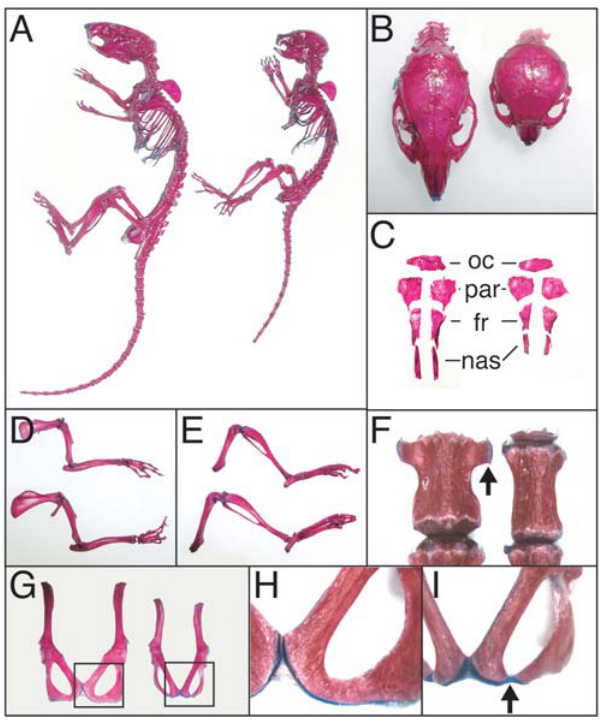
Figure 3. Skeletal defects in R26 floxneoWnt4 ; Col2a1-Cre mutants. Skeleton preparations from 6-week-old R26 floxneoWnt4 ; Col2a1-Cre mutants and R26 floxneoWnt4 controls. A, Intact skeletons, control (left) and mutant (right). B, Dorsal view of skulls, control (left) and mutant (right). C, individual dorsal skull bones, control (left) and mutant (right). D, Isolated forelimbs, mutant (top) and control (bottom). E, Isolated hindlimbs, mutant (top) and control (bottom). F, Third lumbar vertebrae, showing lateral ossifications (arrow) in the control (left) that are hypoplastic in the mutant (right). G, Isolated pelvic bones from 6- week-old mice, control (left) and mutant (right). H, Higher magnification of boxed region shown in panel G, showing pubic and ischial bone fusion of the control. I, Higher magnification of boxed region shown in panel G, showing lack of fusion between the pubic and ischial bones of the mutant. fr, frontal bone; nas, nasal bone; par, parietal bone; oc, occipital bone.